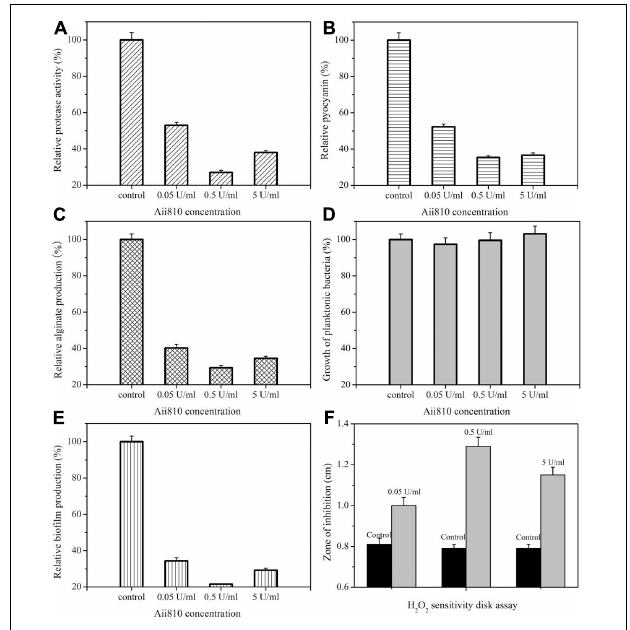
FIGURE 7 | Effect of Aii810 on the production of virulence factors and biofilm, and growth inhibition by H 2 O 2 of Pseudomonas aeruginosa PAO1. Extracellular protease activity (A) , pyocyanin production (B) , alginate production (C) , growth of planktonic bacteria (D) , and biofilm production (E) . Growth inhibition by H 2 O 2 of Aii810-treated PAO1 (gray bars) was compared with untreated PAO1 (black bars) (F) . All experiments were performed in triplicate. Averages of the triplicate experiments were used to represent each of the three experiments. The data were shown as means ± the standard deviation